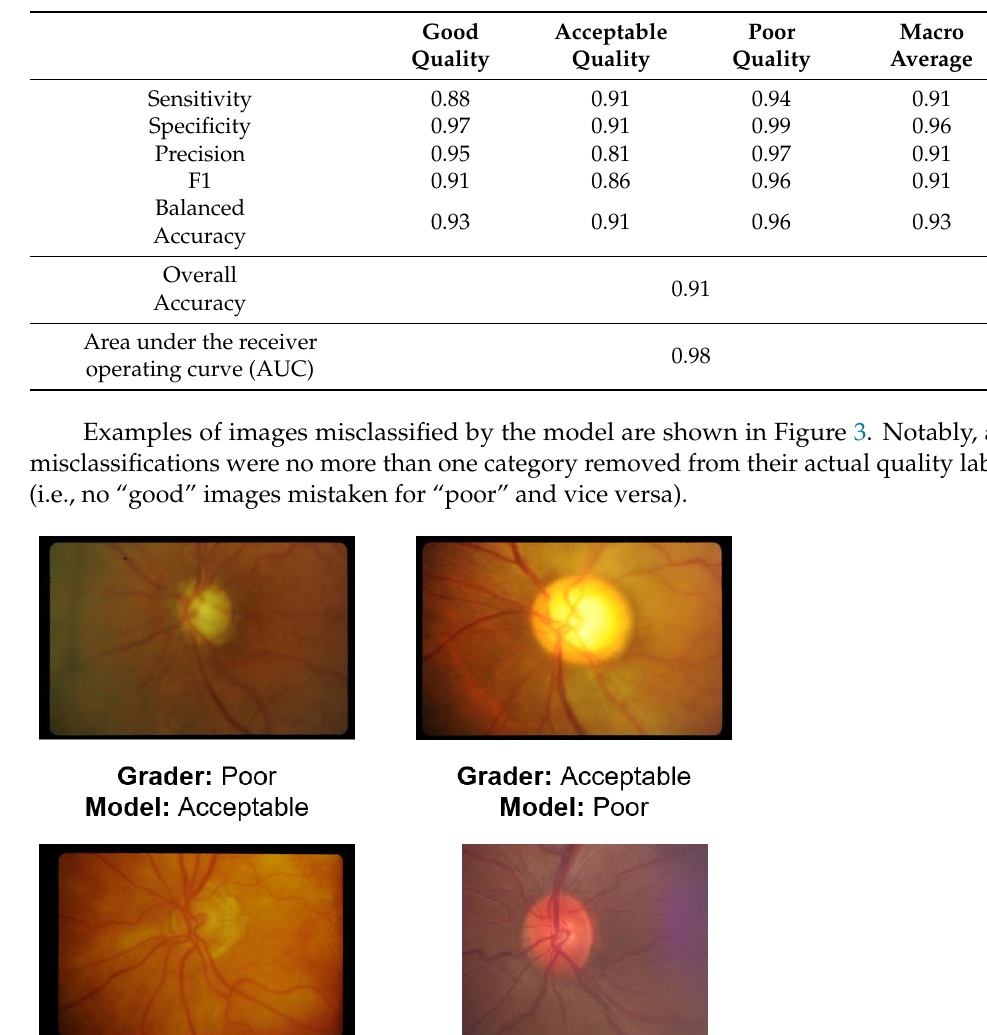
Table 2. Per-class and macroaverage performance metrics for the ternary classification model.